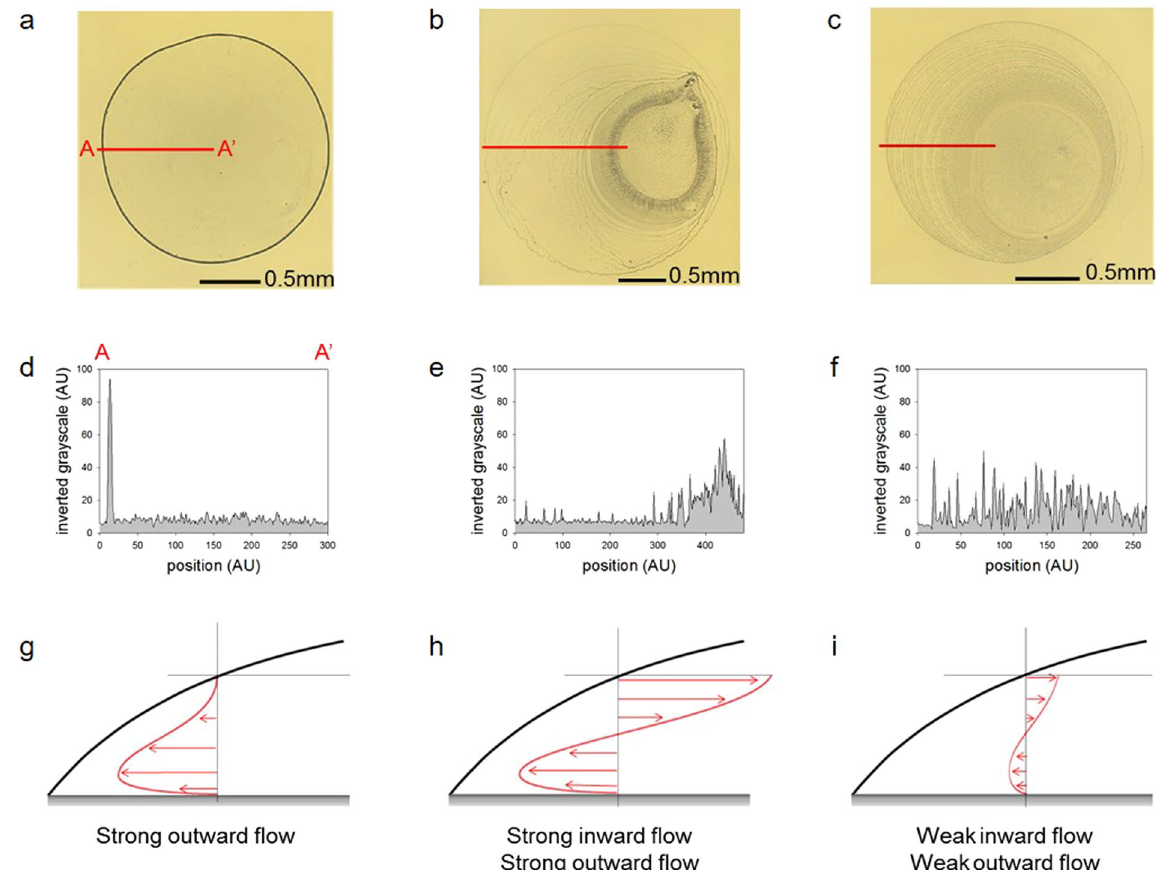
Figure 1. Deposition patterns of the droplets and schematic image of fluidic motion in the evaporating droplets. Magnified bottom views of the deposition patterns of droplets of the ( a ) DIw and ( b ) SDS and ( c ) PEG solutions. Profiles of the inverted greyscale intensity of the ( d ) DIw and ( e ) SDS and ( f ) PEG solutions. Schematic cartoons of the fluidic motions in the evaporating droplets of the ( g ) DIw and ( h ) SDS and ( i ) PEG